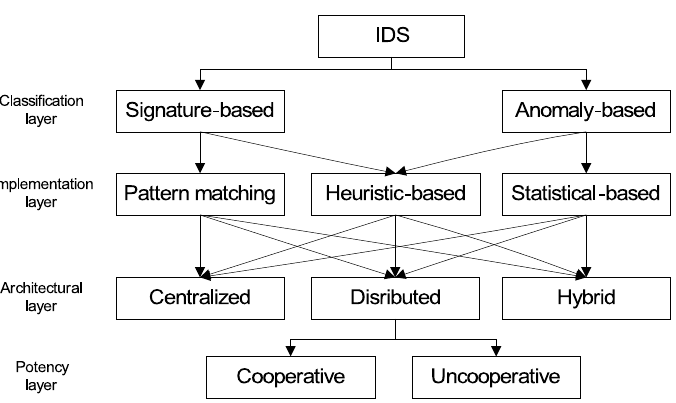
Figure 1. Taxonomy of intrusion detection